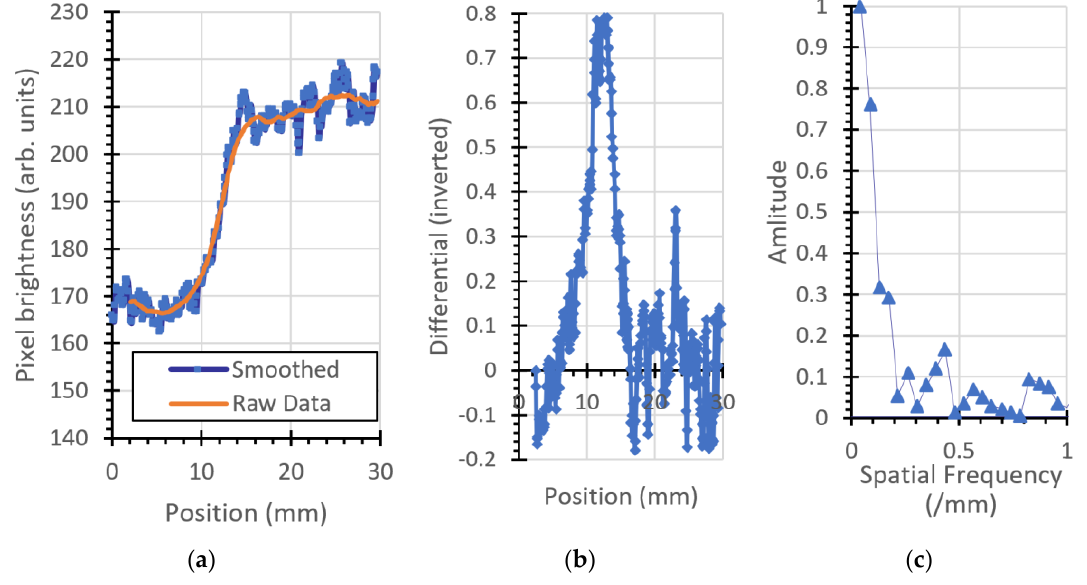
Figure 8. Vertical edge, top part of Adelphi’s logo: ( a ) ESF, ( b ) LSF, and ( c ) MTF.